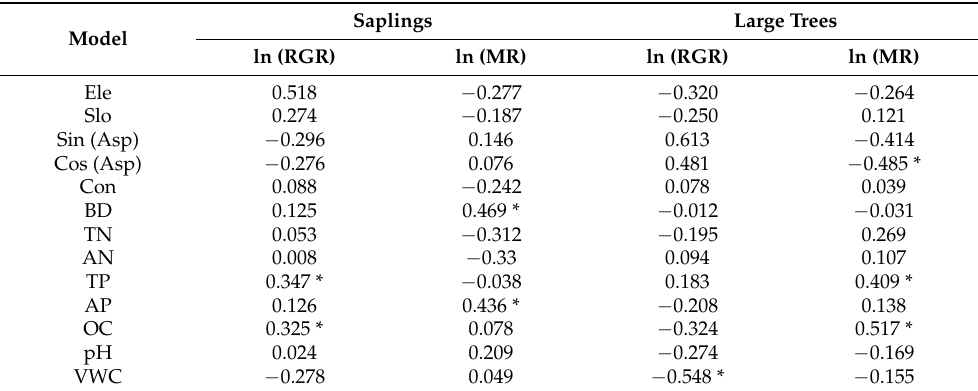
Table 2. Pearson correlation coefficients for relationships between RGR and MR and topographical and soil-based factors for saplings and large trees in a 9 ha mixed broadleaved Korean pine forest dynamic plot in China.